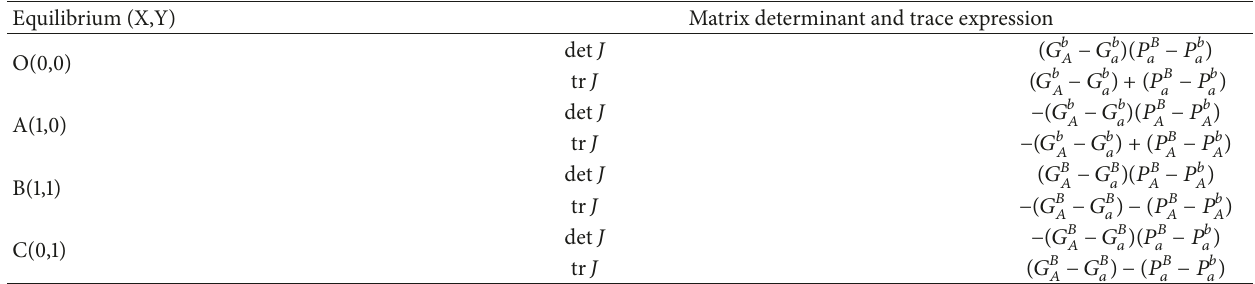
Table 3: Matrix determinant and trace expression corresponding to equilibrium.